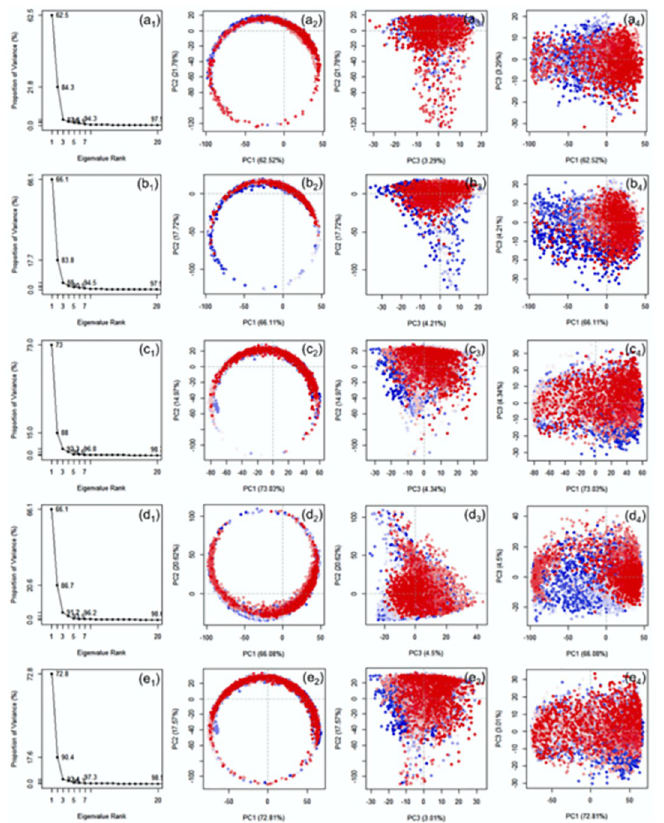
Fig 14. Principal component analysis for the simulation trajectories generated at 310K with varied pH values, viz. pH5 (a principal component. The scatter plots represent the distribution of extracted essential motion between two PCs while colour change from red to blue through white marks for the periodic fluctuations experienced by the residue during 100 ns MD